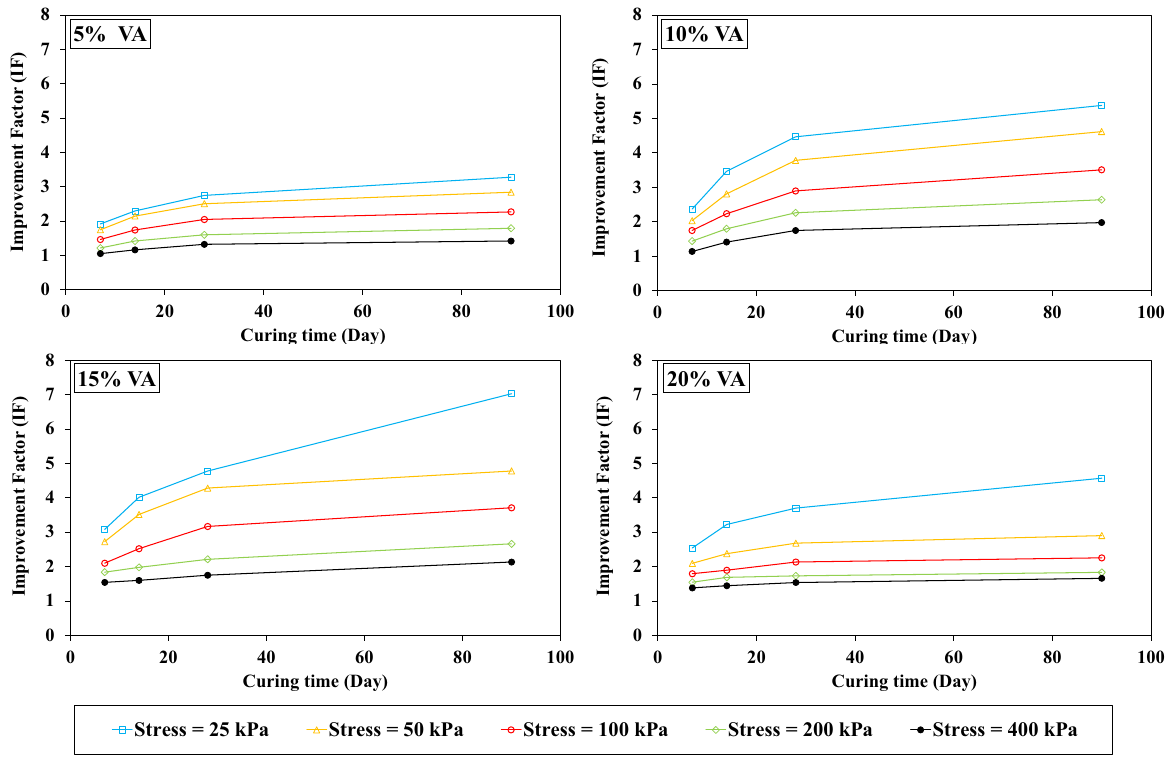
Figure 13. Influence of the curing time on the improvement factor (IF) for the optimum moisture content (OMC) conditions.